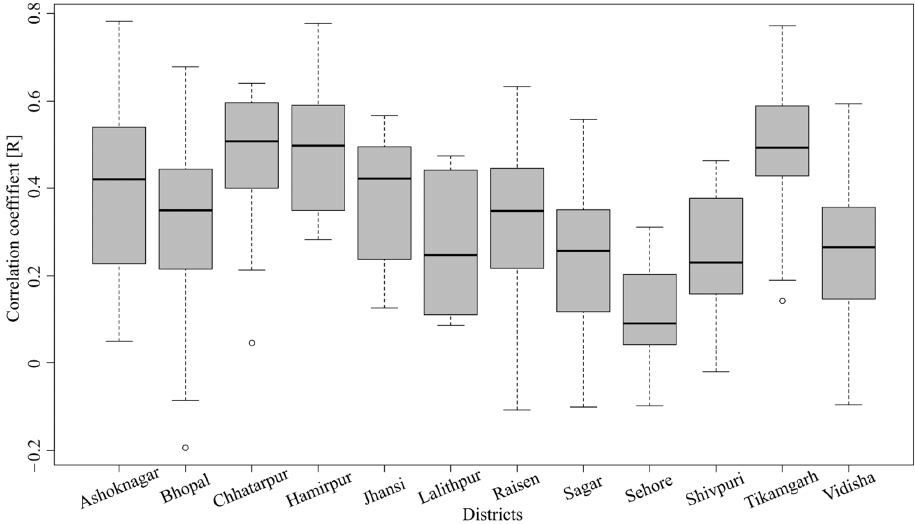
Figure 10. District ‐ wise correlation coefficient ( R ) between groundwater fluctuation and the mon ‐ Figure 10. District-wise correlation coefficient ( R ) between groundwater fluctuation and the monsoon soon rainfall. The extended dashed lines represent the minimum and maximum R ‐ value ranges. The rainfall. The extended dashed lines represent the minimum and maximum R -value ranges. The horizontal line in the box (solid black) represents the median value. horizontal line in the box (solid black) represents the median